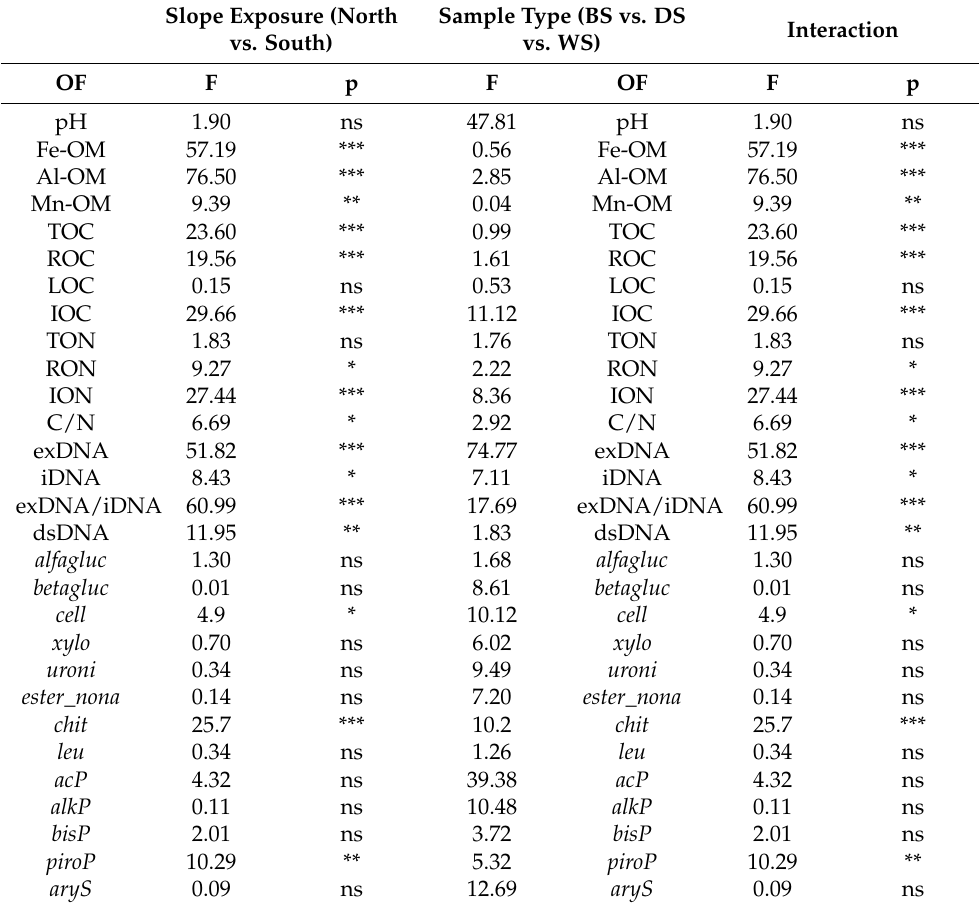
Table 3. Statistical output of the physico-chemical and microbiological parameters as a function of slope exposure (north- vs. south-facing sites) and between bulk soil (BS) and aggregate sizes fractions (dry-sieved [DS] and water-stable [WS] 1.00–0.50 mm) in the organic (OF) horizon. Slope Exposure